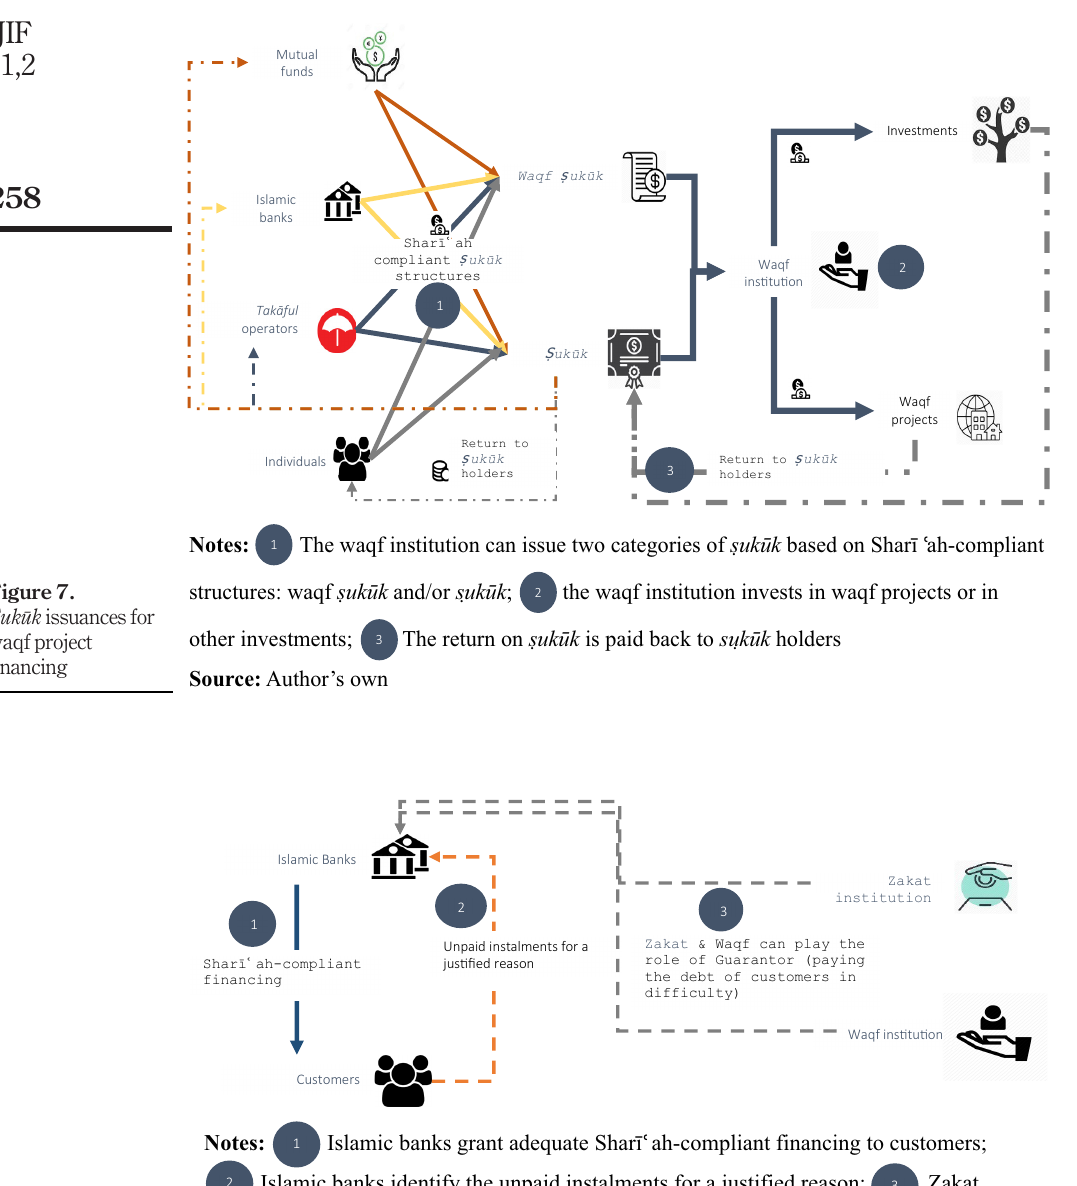
Figure 8. Zakat and waqf institutions